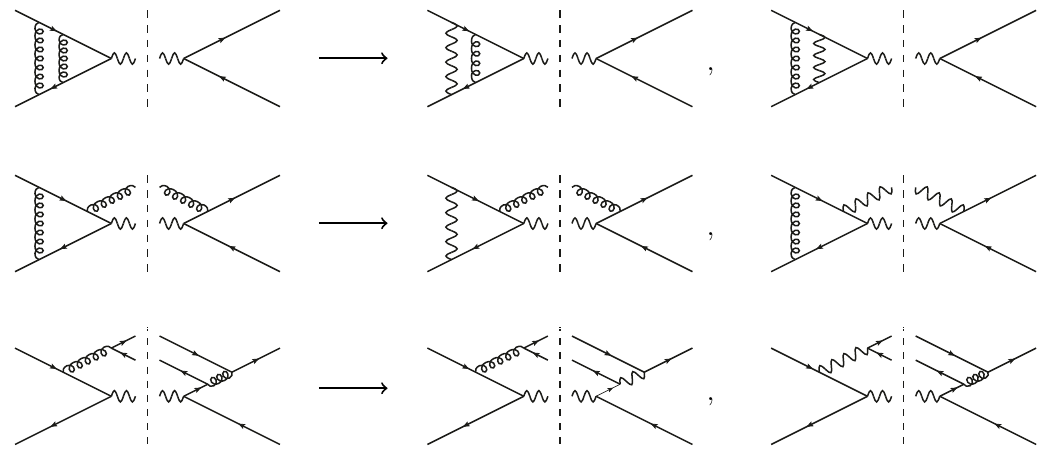
Figure 2. Contributions to the colour factor C 2